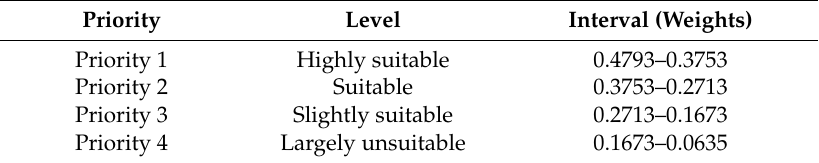
Table 9. Classification